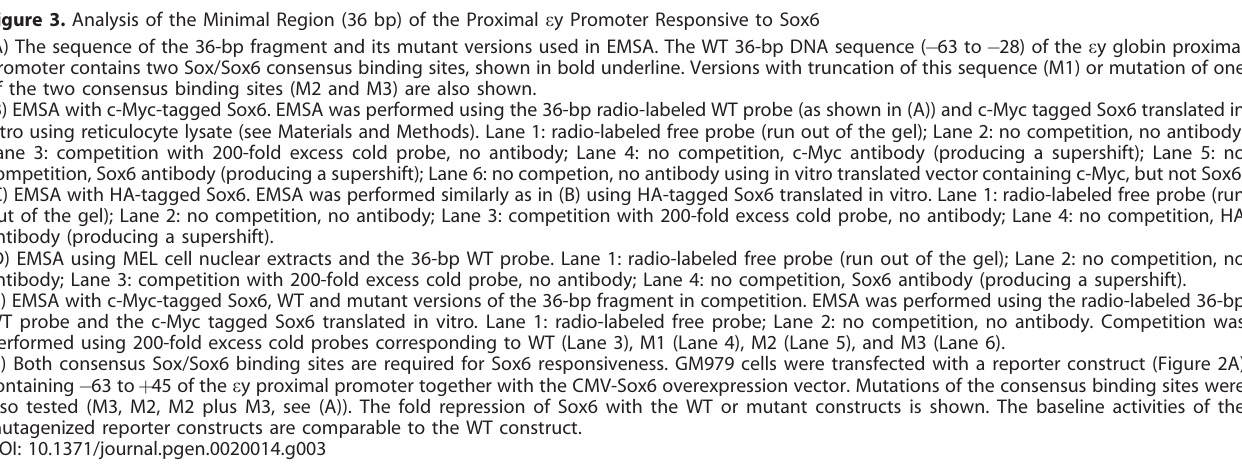
Figure 3. Analysis of the Minimal Region (36 bp) of the Proximal e y Promoter Responsive to Sox6 (A) The sequence of the 36-bp fragment and its mutant versions used in EMSA. The WT 36-bp DNA sequence ( (cid:1) 63 to (cid:1) 28) of the e y globin proximal promoter contains two Sox/Sox6 consensus binding sites, shown in bold underline. Versions with truncation of this sequence (M1) or mutation of one of the two consensus binding sites (M2 and M3) are also shown. (B) EMSA with c-Myc-tagged Sox6. EMSA was performed using the 36-bp radio-labeled WT probe (as shown in (A)) and c-Myc tagged Sox6 translated in vitro using reticulocyte lysate (see Materials and Methods). Lane 1: radio-labeled free probe (run out of the gel); Lane 2: no competition, no antibody; Lane 3: competition with 200-fold excess cold probe, no antibody; Lane 4: no competition, c-Myc antibody (producing a supershift); Lane 5: no competition, Sox6 antibody (producing a supershift); Lane 6: no competion, no antibody using in vitro translated vector containing c-Myc, but not Sox6. (C) EMSA with HA-tagged Sox6. EMSA was performed similarly as in (B) using HA-tagged Sox6 translated in vitro. Lane 1: radio-labeled free probe (run out of the gel); Lane 2: no competition, no antibody; Lane 3: competition with 200-fold excess cold probe, no antibody; Lane 4: no competition, HA antibody (producing a supershift). (D) EMSA using MEL cell nuclear extracts and the 36-bp WT probe. Lane 1: radio-labeled free probe (run out of the gel); Lane 2: no competition, no antibody; Lane 3: competition with 200-fold excess cold probe, no antibody; Lane 4: no competition, Sox6 antibody (producing a supershift). (E) EMSA with c-Myc-tagged Sox6, WT and mutant versions of the 36-bp fragment in competition. EMSA was performed using the radio-labeled 36-bp WT probe and the c-Myc tagged Sox6 translated in vitro . Lane 1: radio-labeled free probe; Lane 2: no competition, no antibody. Competition was